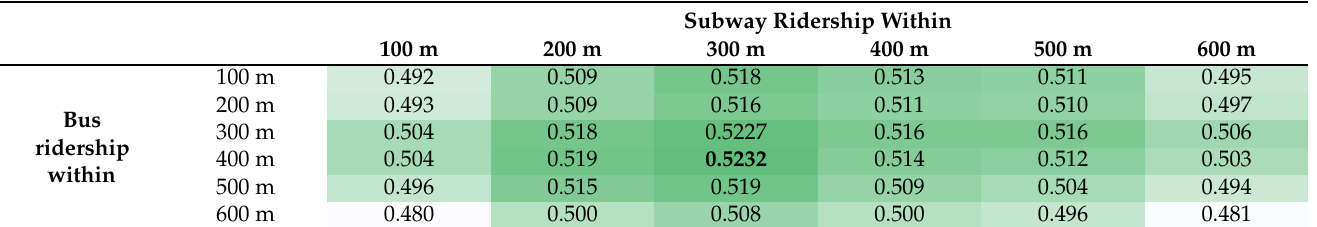
Table 3. The explanatory power (Pseudo-R 2 ) of the spatial error models by the transit stop/station’s influential area